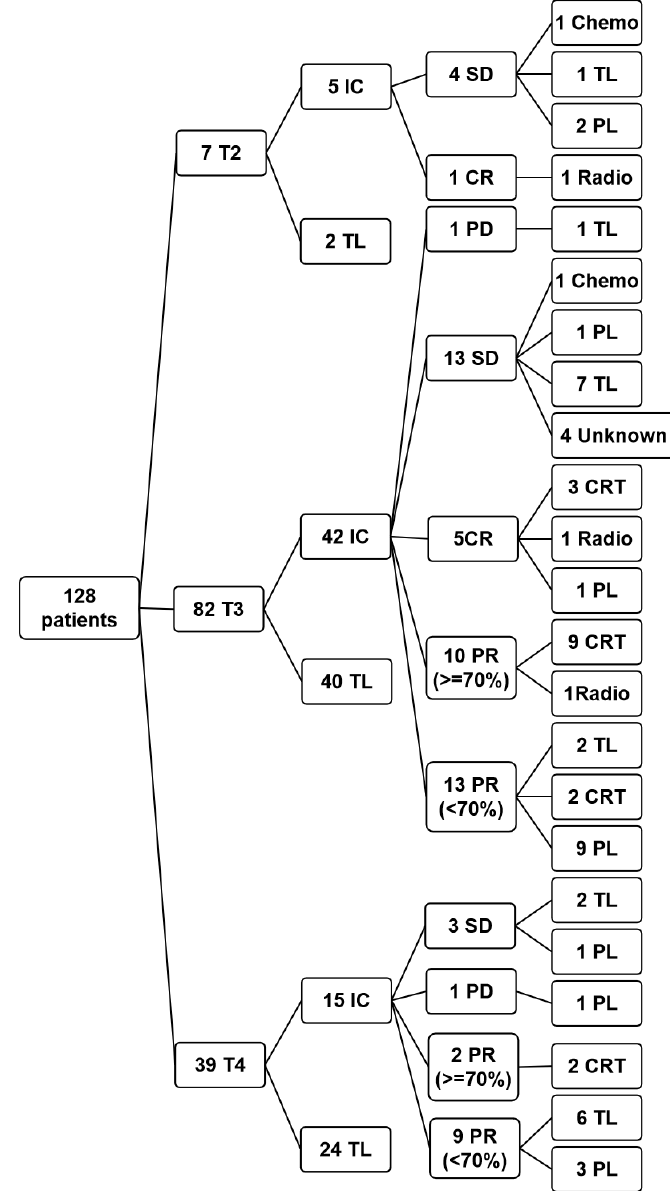
Figure 1. A flow diagram about the treatment protocol and groups. IC: induction chemotherapy; TL: total laryngectomy; SD: stable disease; PD: progressive disease; PR: partial response; CR: complete response; Chemo: chemotherapy; Radio: radiotherapy; PL: partial laryngectomy; CRT: current radiochemotherapy; Unknown: these patients preferred not to provide information about their treatments.